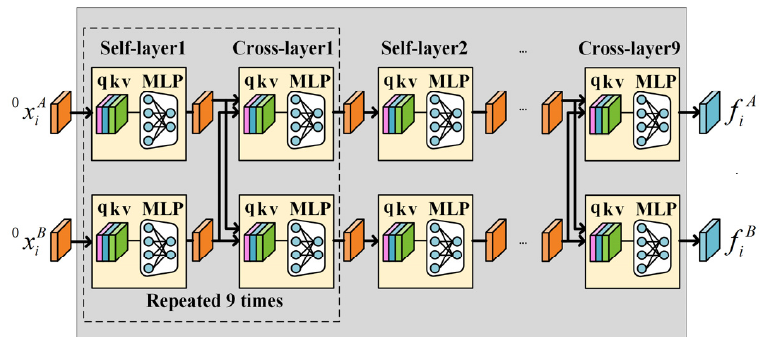
Figure 7. The architecture of GNN. The q, k, and v represent the query, key, and value in the attention mechanism. x is obtained by FPE. The self-layer and cross-layer are repeated nine times alternatively.